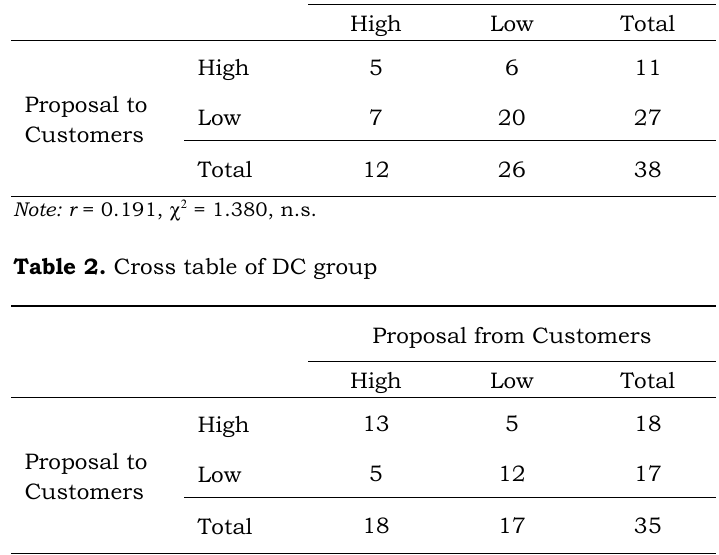
Table 1. Cross table of low DC group Proposal from Customers High Low Total